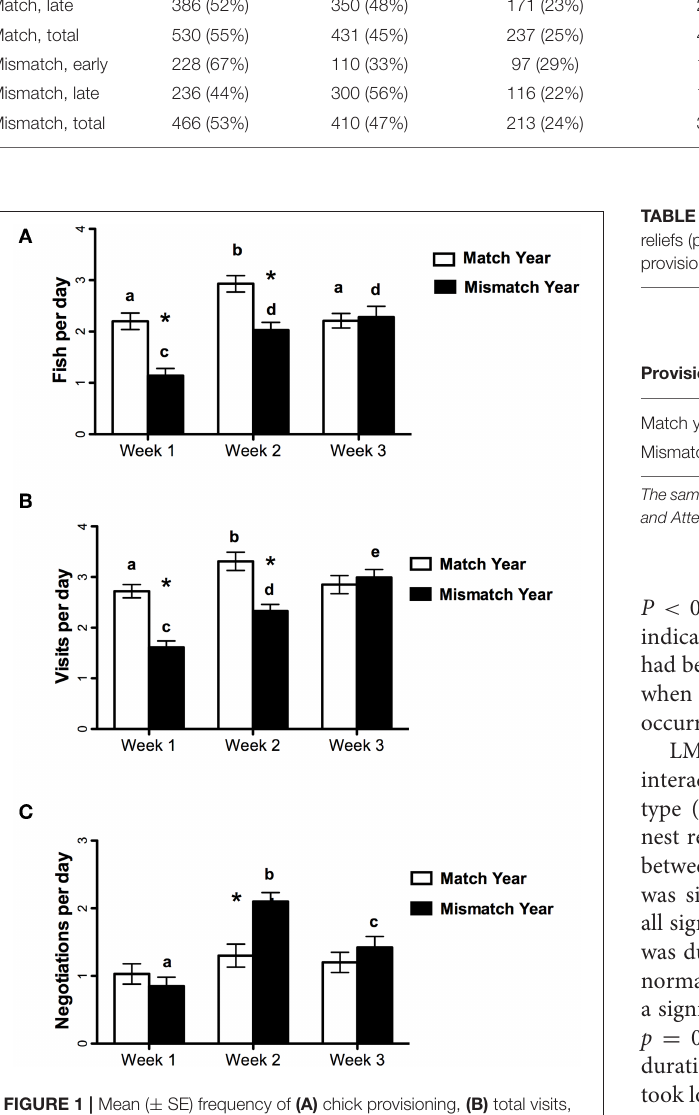
FIGURE 1 | Mean ( ± SE) frequency of (A) chick provisioning, (B) total visits, and (C) negotiation for weeks 1–3 after chick hatching in the match year (1999) and mismatch year (2000). Different letters within the same year indicate significant differences over weeks whereas * indicates a significant difference between the same week in the 2 years.